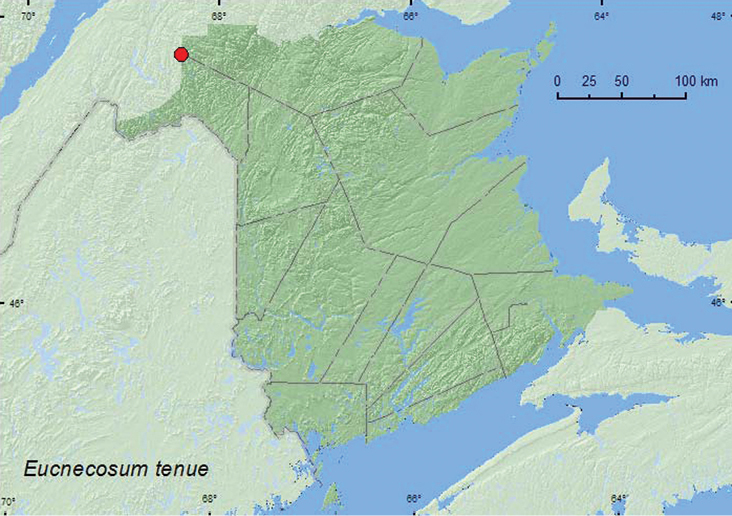
Collection localities in New Brunswick, Canada of Eucnecosum tenue.